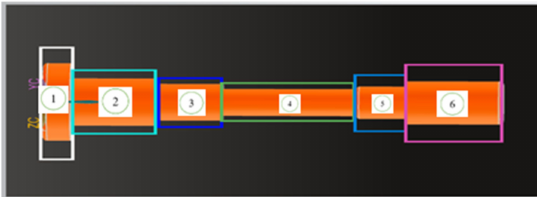
Figure 3. SPB divided into six